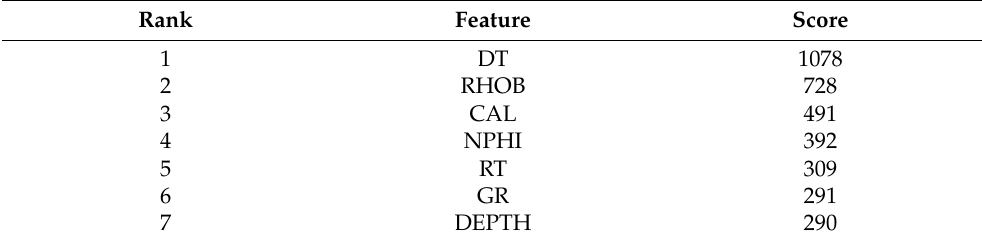
Table 2. Importance scores of the parameters based on the LightGBM